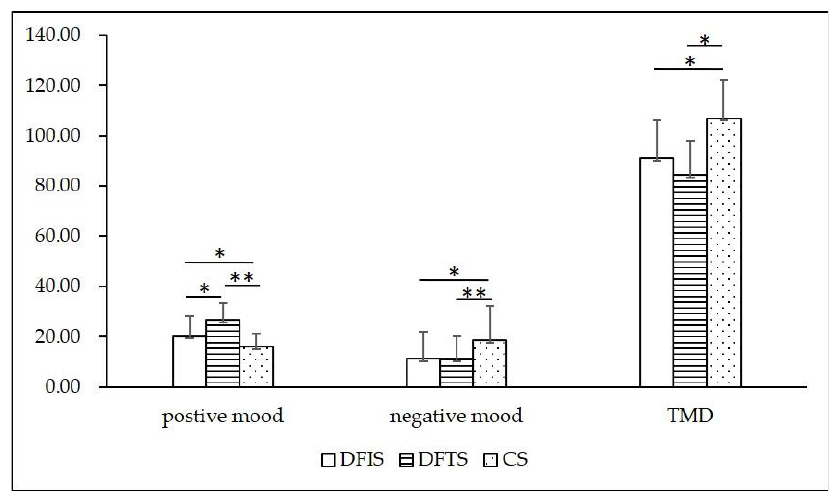
Figure 8. Mood state values for the three stimulating environments ( n = 120; mean ± SD; * p < 0.05; ** p < 0.01; verified by Wilcoxon signed-rank test; DFIS: deciduous forest interior setting; DFTS: deciduous forest trail setting; CS: city setting; “TMD” means “total mood”).